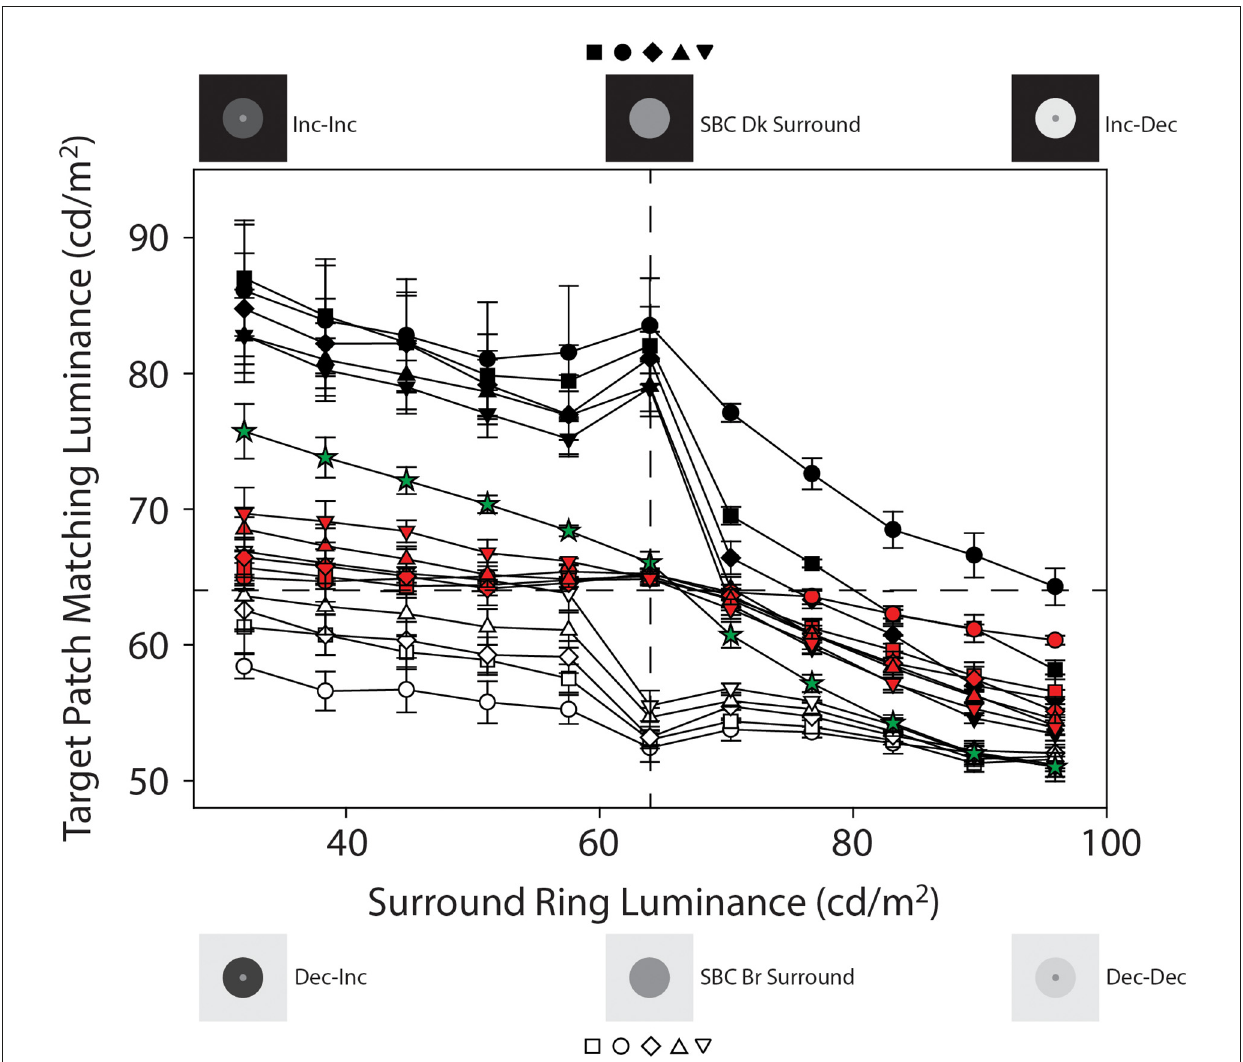
FIGURE3 Mean target patch matching luminance from Experiments 1 and 2 plotted as a function of adjacent surround-ring luminance, averaged across the four observers ( ± 1 SEM). The symbol shapes represent the various adjacent surround-ring widths (0.1 ◦ = circles, 0.3 ◦ = squares, 0.5 ◦ = diamonds, 1.0 ◦ = triangles, 2.5 ◦ = inverted triangles). The red, black, and white symbol colors indicate the three different remote background luminance conditions on which the target patch plus adjacent surround-ring combinations were presented (red = 64 cd/m 2 , black = 0.0 cd/m 2 , white = 96 cd/m 2 ). The green stars plot the results for the condition in which the adjacent surround-ring filled the entire background of the stimulus (50 ◦ ). The surround-ring in this condition assumed the same luminance values (32 cd/m 2 –96 cd/m 2 ) as the adjacent surround-rings in the other conditions. The horizontal dashed line represents a veridical luminance match to the target patch (64 cd/m 2 ) and the vertical dashed line indicates the location where adjacent surround-ring luminance equals target patch luminance. The stimulus icons appearing at the top and bottom of Figure 3 depict the luminance relationships between the target patch (64 cd/m 2 ) and variable adjacent-surround rings, on the dark and bright remote backgrounds (see text for details).